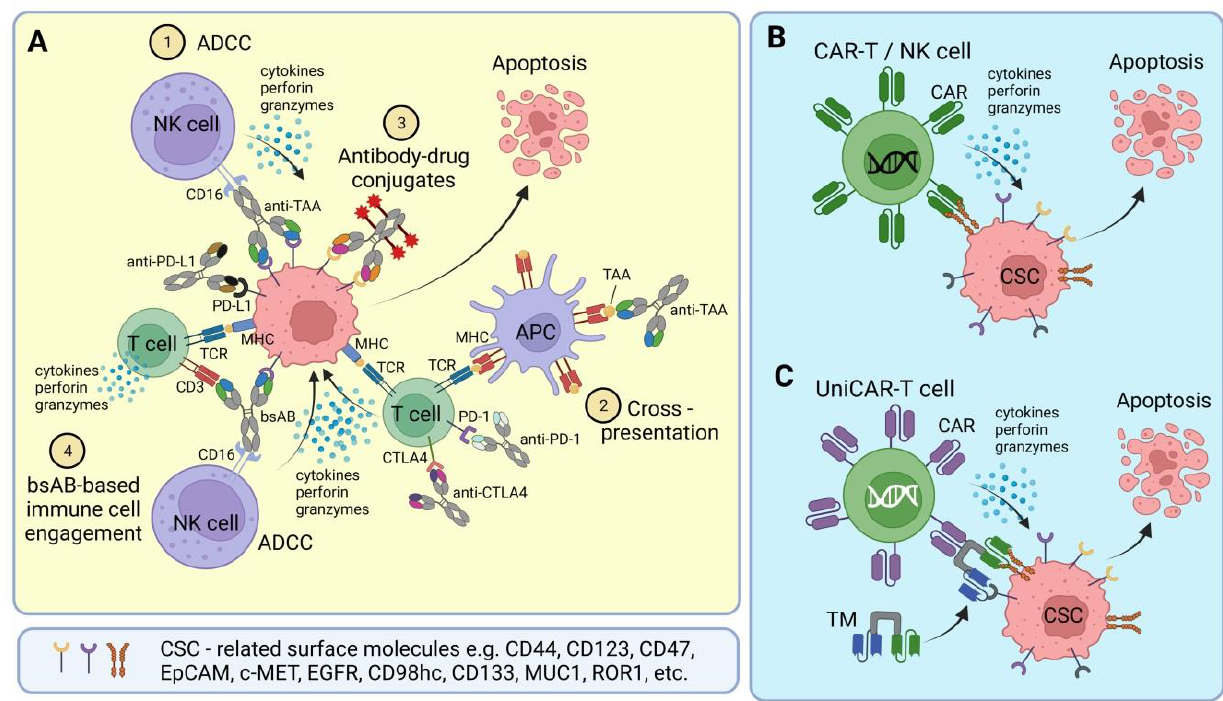
Figure 1. CSC-directed immunotherapeutic approaches. ( A ) Therapeutic antibody induces immune-mediated tumor cell killing by the induction of antibody-dependent cellular cytotoxicity (ADCC) (1). Antibody-mediated antigen delivery to the antigen-presenting cells (APC), such as dendritic cells (DCs), leads to effective T cell activation (2). T cells are also activated by inhibition of the immune checkpoint proteins: cytotoxic T-lymphocyte-associated protein 4 (CTLA-4), programmed cell death protein 1 (PD-1), and its ligand, PD-L1. Antibody-drug conjugates deliver potent chemotherapeutic agents to the target cells positive for a tumor-associated antigen (TAA) (3). Bispecific antibodies (bsAB) retarget immune cells to the TAA-expressing tumor cells (4). ( B ) CAR-T cells/CAR-NK cells are T or natural killer (NK) cells that are genetically modified with artificial chimeric antigen receptor (CAR) recruiting them to tumor cells. ( C ) Universal CAR (UniCAR) T cells recognize tumor cells via a short-lived target module (TM) which could be designed against more than one TAA. CAR — chimeric antigen receptor; CSC — cancer stem cells; MHC — major histocompatibility complex; TCR — T cell receptor. Created with BioRender.